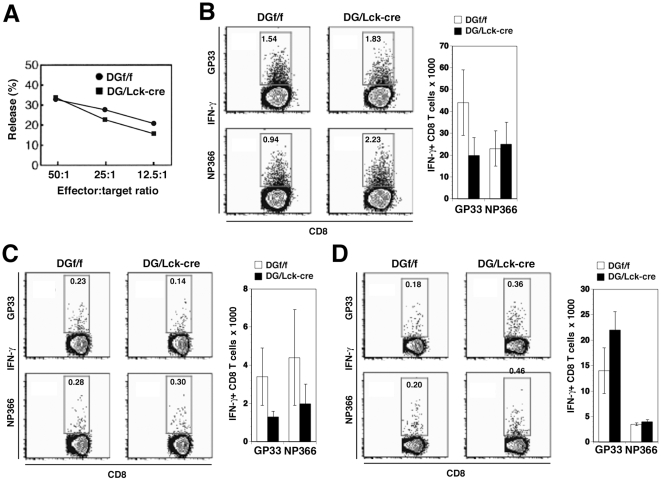
DG Null (DG/Lck-cre) Mice and Control (DGf/f) Mice Generate Equivalent Functional Virus-Specific CD8+ T Cell Responses After Challenge with Influenza Virus.DG/Lck-cre mice and littermate controls (DGf/f) were inoculated intratracheally with 1×105 pfu of recombinant influenza virus that also expressed the immunodominant Db LCMV CD8 epitope GP33. The normal influenza immunodominant epitope is NP366. (A) Eight days post-infection, the cytotoxicity of pulmonary CD8+ T cells was assessed by 51Cr release by NP366 peptide-pulsed target cells. Lungs from five mice were pooled per group. Virus-specific CD8+ T cells from lung (B), draining mediastinal lymph node (C) and spleen (D) were detected in mice 8 days post-infection by intracellular staining for IFN-γ following a 5 h incubation in the presence of indicated peptides. There was no statistical difference among T cell functions of DG/Lck-cre mice or DGf/f littermate controls in any of the various tissue compartments. Four to five mice used per group.